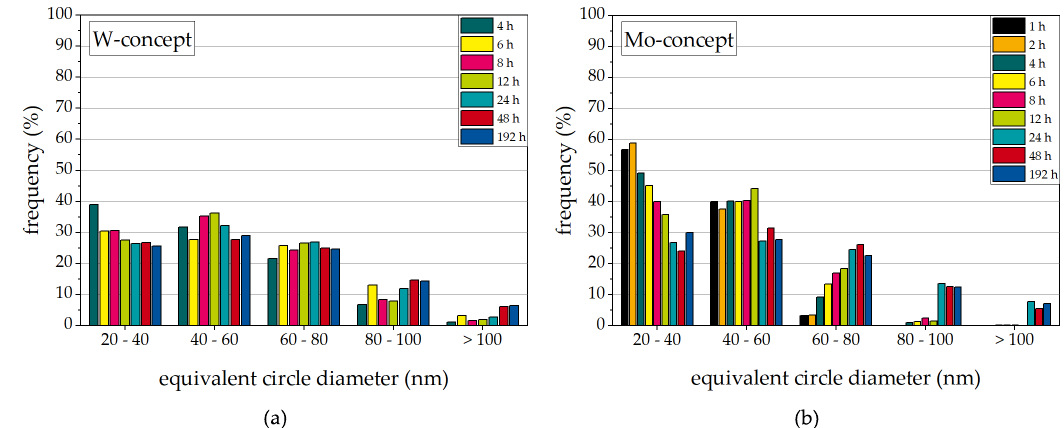
Figure 6. ECD of W- ( a ) and Mo-concept ( b ) as function of aging time at